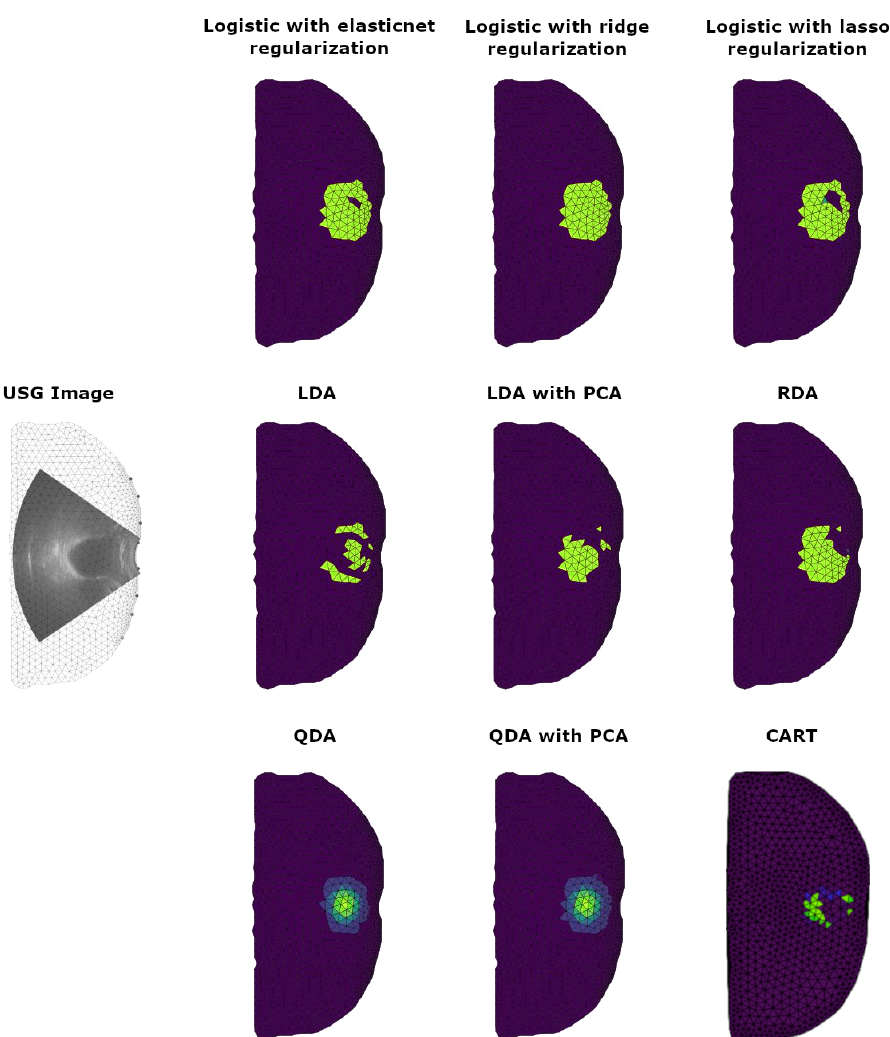
Figure 14. Comparison of results obtained for real measurement data using introduced discretization methods. As a reference, we show the USG image for the bladder superimposed on the finite element mesh with the proportions